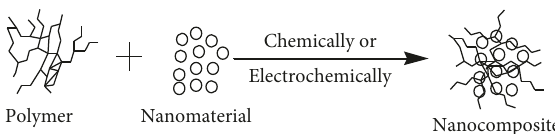
Figure 5: Forms of common nanomaterials. (a) Nanolayer. (b) Nanorod or nanofibre. (c) Nanoparticle. Figure 6: Ex situ nanocomposite synthesis